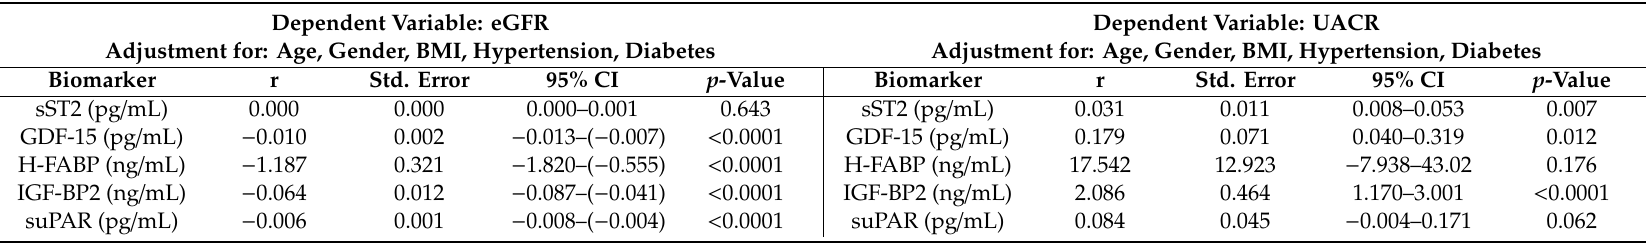
Table A2. Multiple linear regression analysis with adjustment for age, gender, BMI, hypertension and diabetes